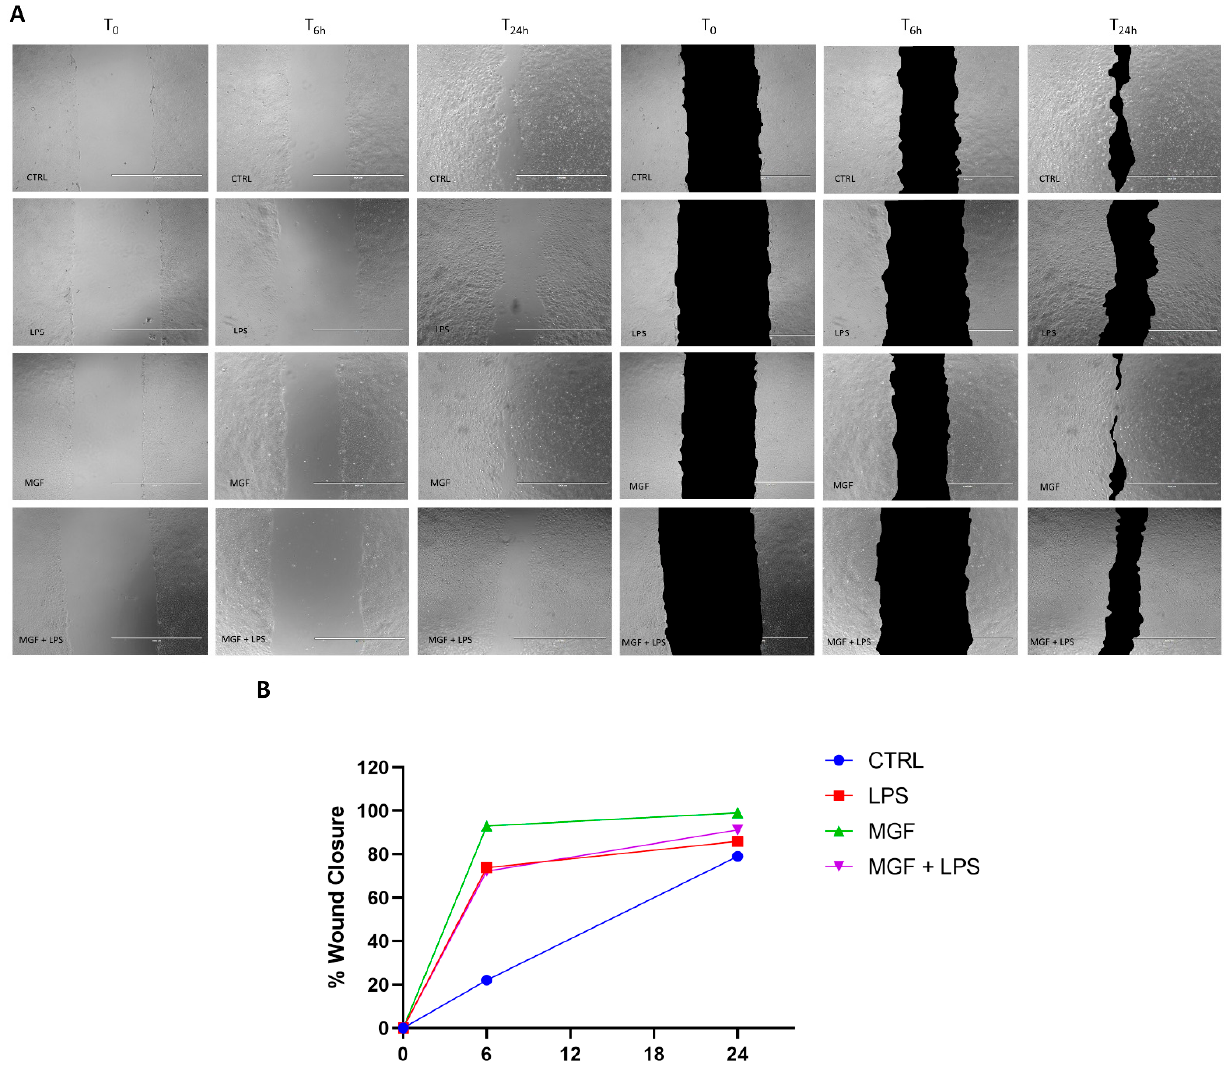
Figure 5. Promoting effects of MGF on wound repairing in presence of LPS in NCI-H292 cells. ( A ) representative images of wound healing assays (left) with highlight of wound closing area (right). Cells were treated with LPS 10 μ g/mL and with MGF 20 μ g/mL immediately after the scratch at 0 h, 6 h, and 24 h of incubation. ( B ) Relative quantification of wound closure. Scale bar = 1000 μ m.